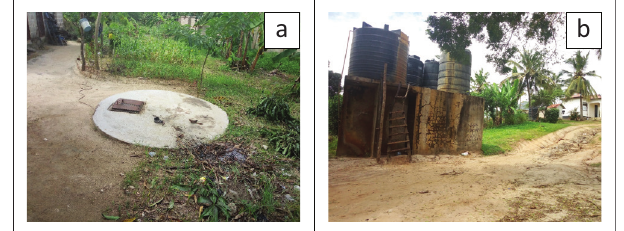
FIGURE 3: (a) Storage tank on the ground surface, (b) Overhead storage tank much safer than ground storage tanks which are risky.